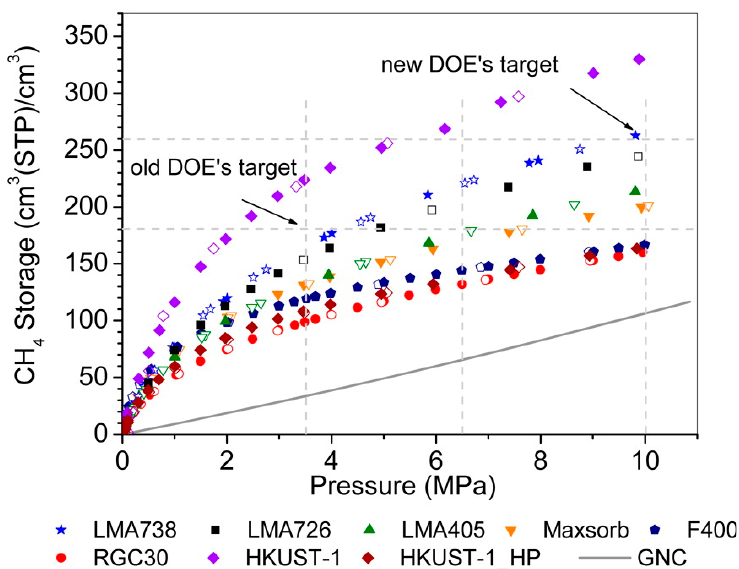
Figure 2. CH 4 storage isotherm for different activated carbons and HKUST-1 at 298 K and pressures of up to 10 MPa. Closed symbols in the figure represent adsorption data and open symbols represent desorption data. The solid line represents compressed natural gas (GNC) or CH 4 storage of bulk CH 4 at 298 K. Adapted with permission from Ref. [89]. Copyright 2015 American Chemical Society.